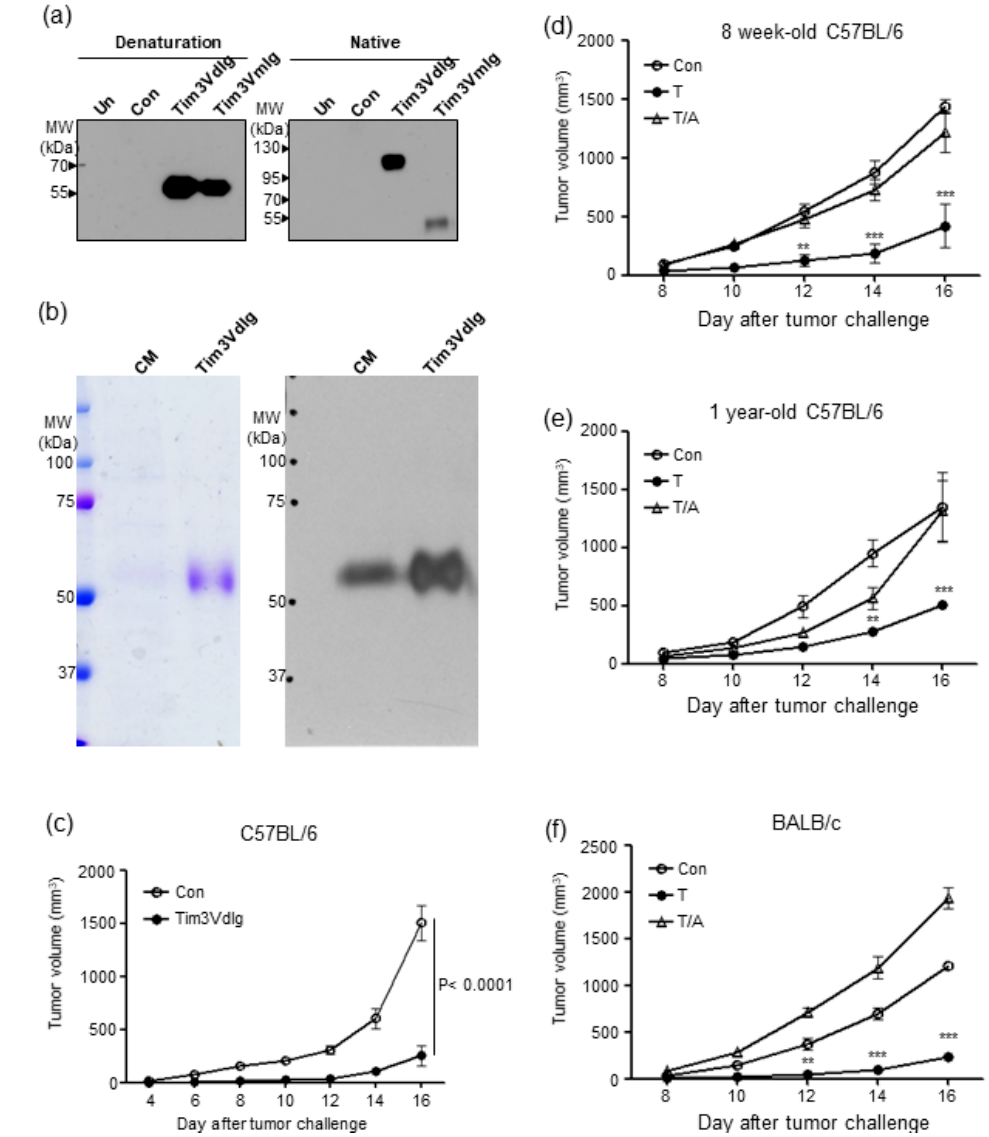
Figure 1. Antibiotic administration hinders the tumour-suppressive effect of Tim3VdIg in two different tumour mouse models. ( a ) Tim3VdIg is expressed as a dimer linked via disulfide bonds between identical polypeptides consisting of the Tim-3 V domain and mouse IgG2a hinge-Fc domain. The culture supernatants of non-transfected CHO cells (Non) and CHO cells transfected with pSecTag2C (Con), pSecTag2C-Tim3VdIg, or pSecTag2C-Tim3VmIg were analysed using Western blotting in both native and denatured conditions. Tim3VmIg lacks the IgG2a hinge region. ( b ) Tim3VdIg purified from culture media of transfected HEK-293T cells was examined using SDS-PAGE (Left) and Western blotting (Right). ( c ) Tumour growth in mice injected with PBS (Con, n = 4) or Tim3VdIg (60 µg/mouse, n = 4) five times, once every second day after B16 melanoma cell challenge (3 × 10 5 ). Tumour growth in 8-week- ( d ) or 1-year- ( e ) old B6 mice injected with B16 cells (3 × 10 5 ). Tumour growth in 8-week-old BALB/c mice ( f ) injected with CT-26 cells (3 × 10 5 ). Tim3VdIg was injected five times, once every second day after tumour challenge, in mice of two groups. One group received orally administered antibiotics (T/A), and the other did not (T). Control group (Con) mice were treated with PBS. Data are presented as mean ± standard deviation. ( n = 3 to 8 per group). ** p < 0.01, *** p < 0.001 vs Con.